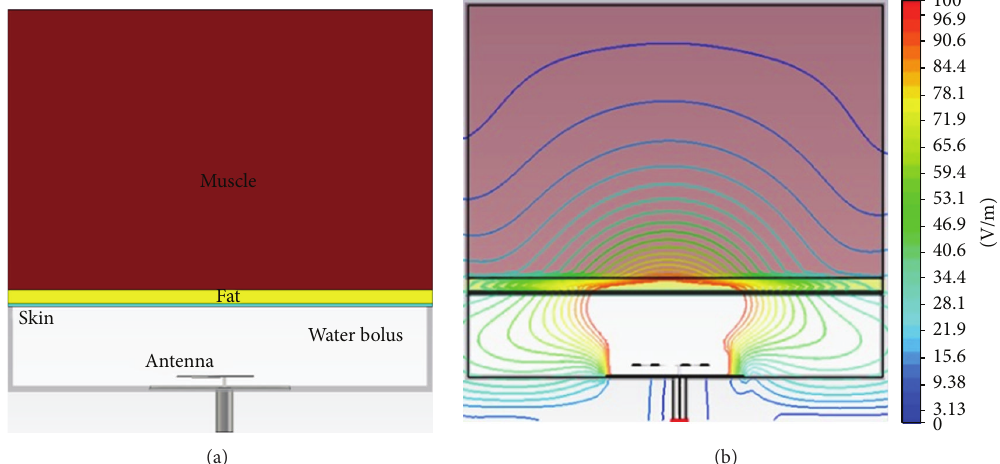
Figure 9: Spiral antenna model inside a water bolus (3cm) with tissues of skin, fat, and muscle (a) and the electric field lines at 434 MHz (b).